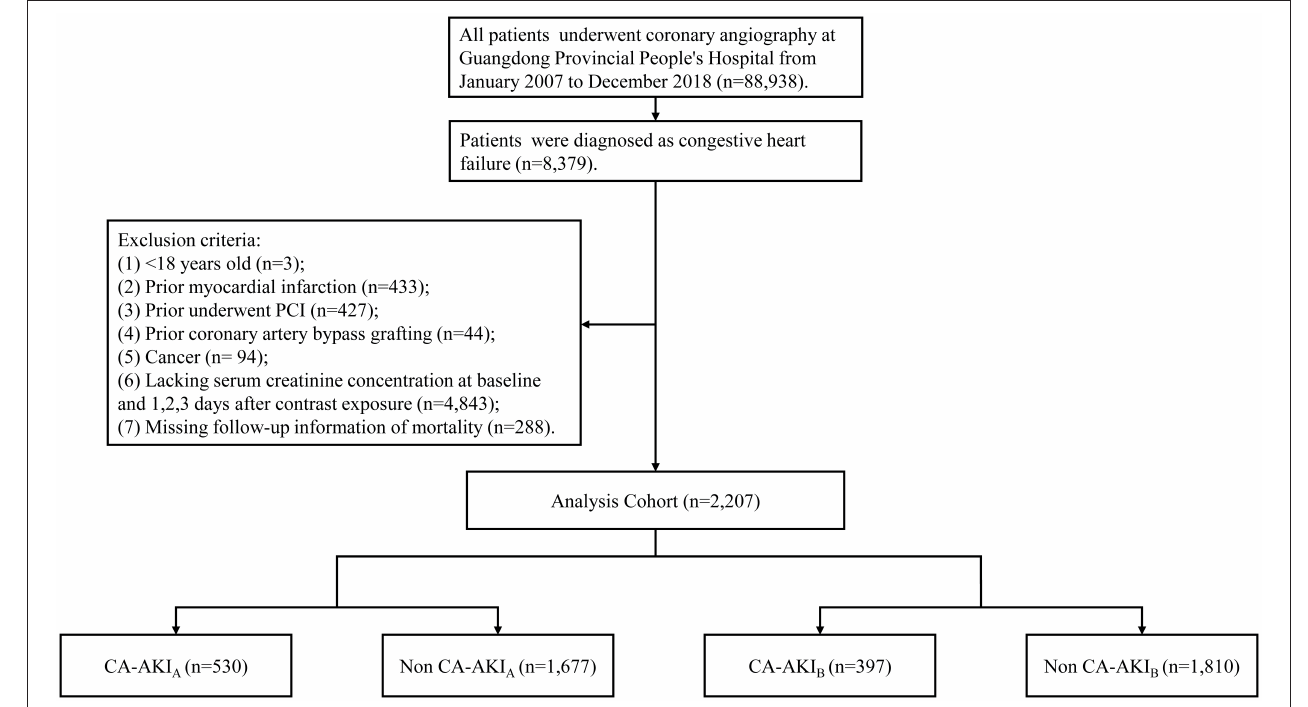
FIGURE 1 | Study flow